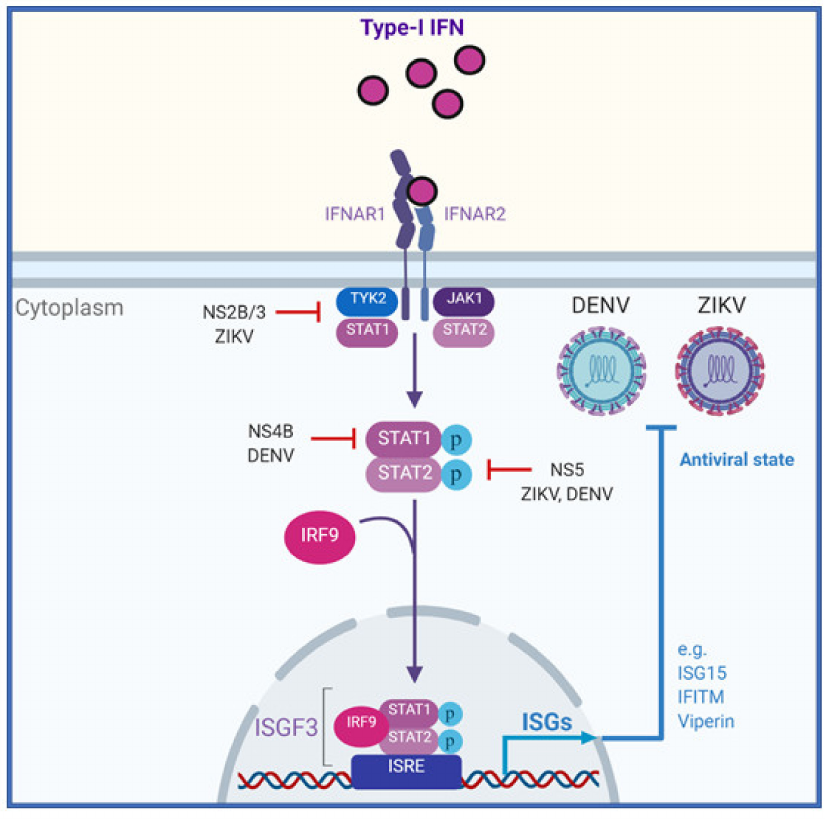
Figure 4. The molecular interactions of ZIKV and DENV with the type-I IFN pathway. Once produced and secreted from infected cells type-I IFNs bind to their cognate cell surface receptor, activating janus kinase-signal transducer and activator (JAK-STAT) signaling (black arrows). This leads to the phosphorylation of STAT1 and STAT2, their heterodimerzation and subsequent complexing with IRF9 to form the complex ISGF3. ISGF3 then transcriptionally upregulates interferon stimulated genes (ISGs) that have antiviral e ff ects against ZIKV and DENV. Several stages of the IFN pathway are inhibited by ZIKV and DENV mediated evasion mechanisms